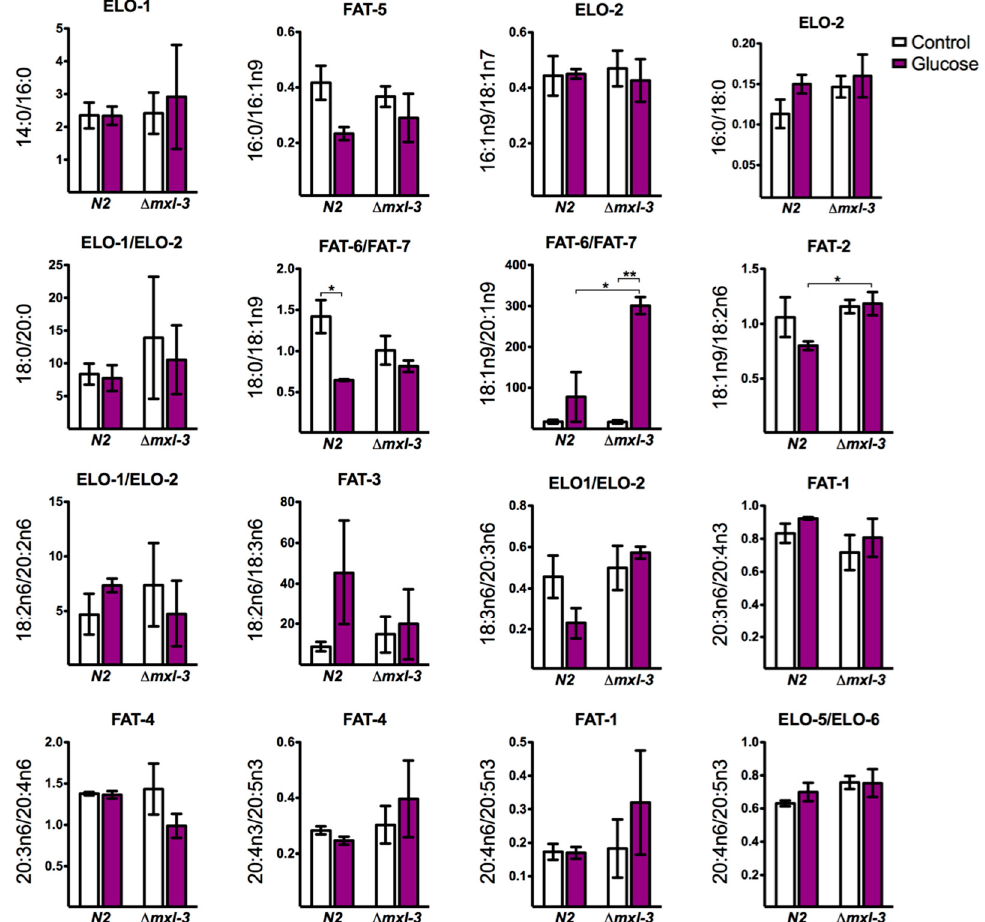
Figure A2. Indirect measurement of the fatty acid biosynthetic pathway. Specific steps in the fatty acid biosynthetic pathway were indirectly measured from substrate/product ratios. If the relationship increased, a decrease in activity was inferred. Each graph shows the mean ± SEM of three independent experiments; * p < 0.05, ** p < 0.01 vs. fatty acids in the control group, one-way ANOVA with Bonferroni’s post hoc test using GraphPad Prism.